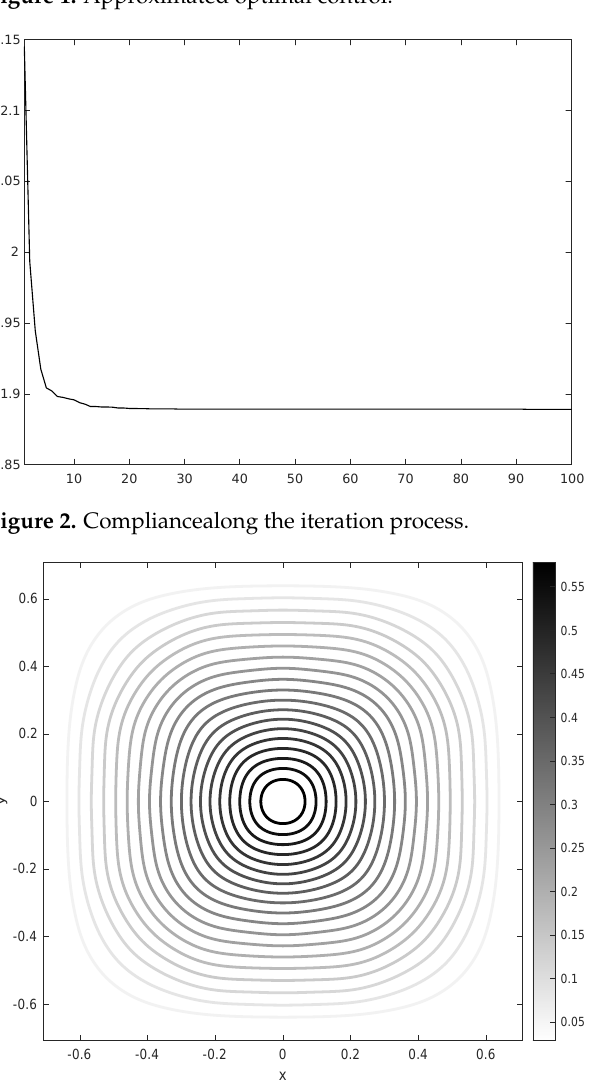
Figure 3. Approximationof the optimal Figure 3: Approximation of the optimal estate